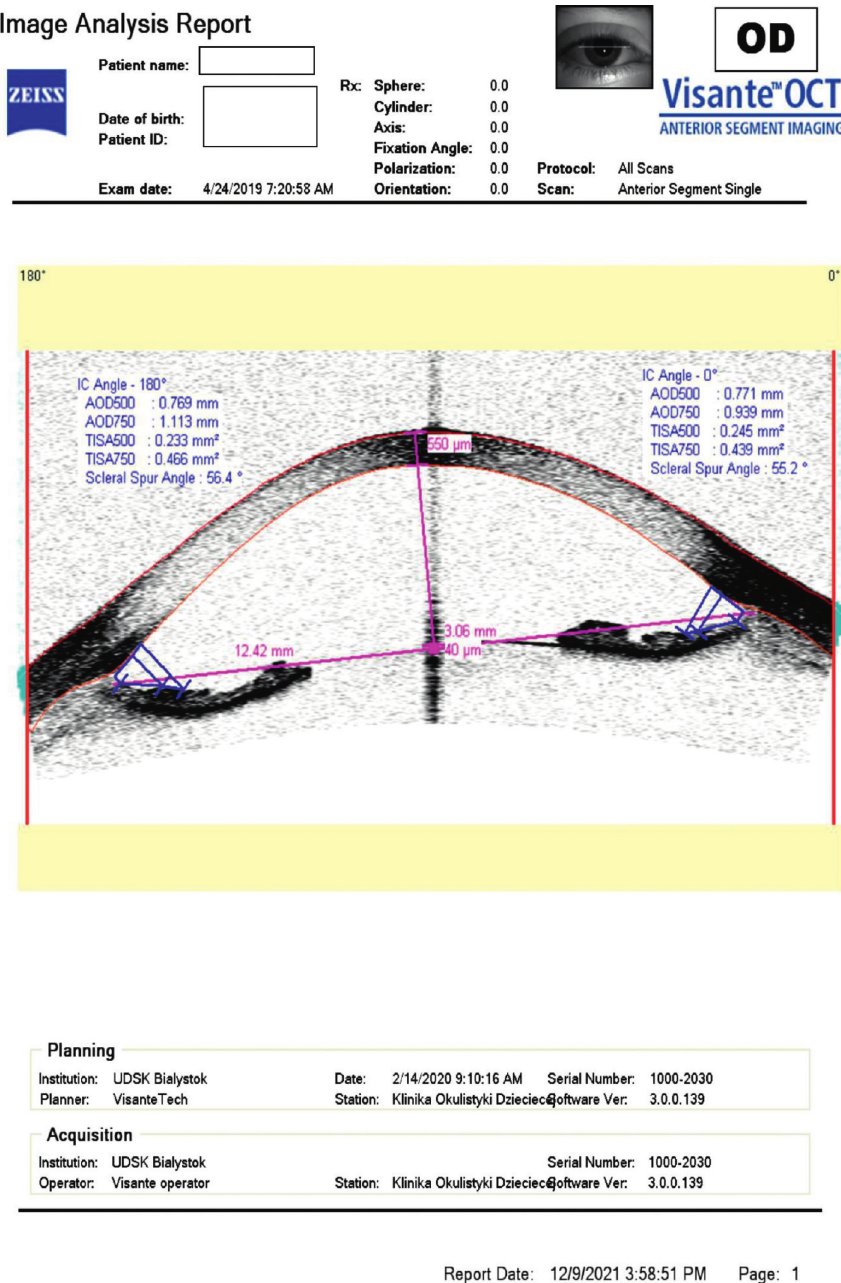
Figure 1: Concave configuration of the iris before